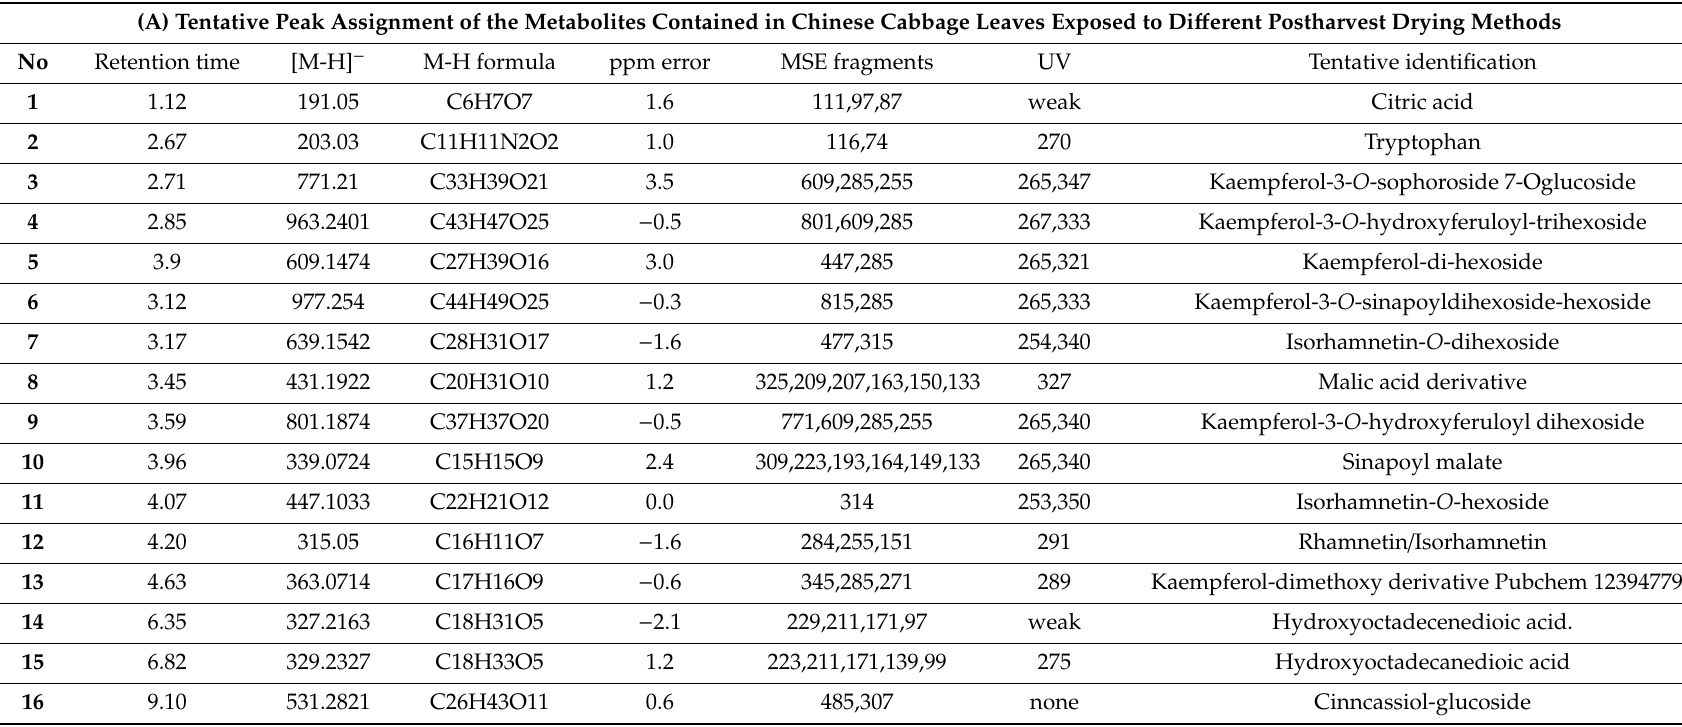
Table 3. Tentative peak assignment of the metabolites contained in Chinese cabbage and Nightshade leaves exposed to di ff erent postharvest drying methods. (A) Tentative Peak Assignment of the Metabolites Contained in Chinese Cabbage Leaves Exposed to Di ff erent Postharvest Drying